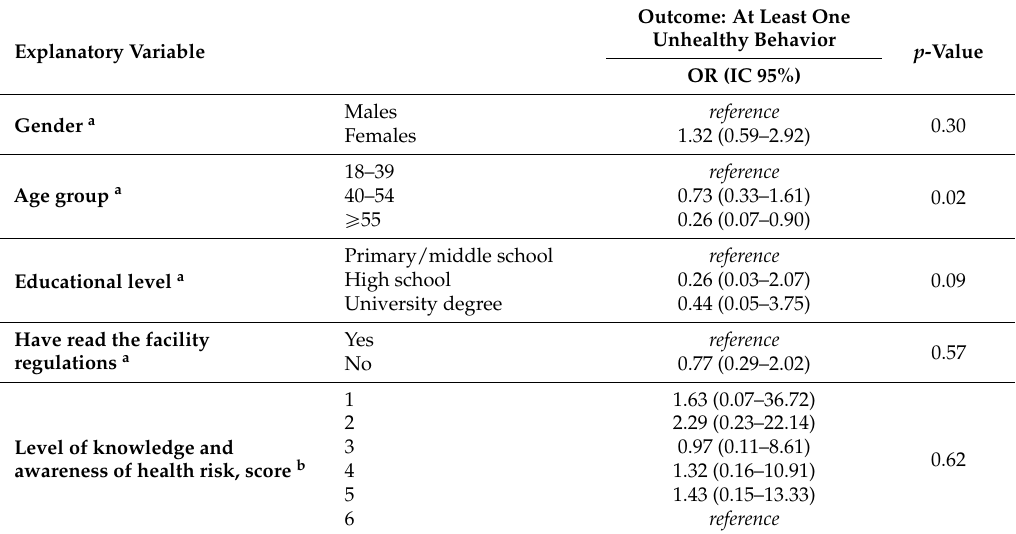
Table 5. Results of the logistic regression model applied to the adult sample ( n =